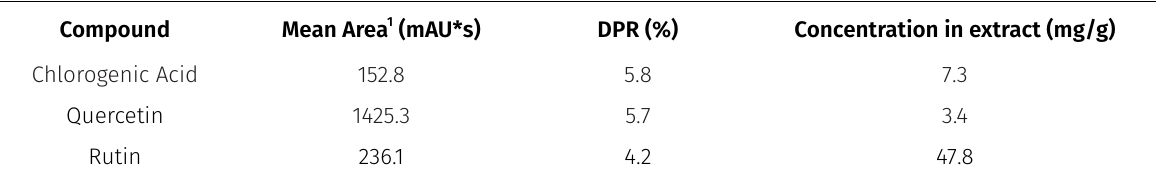
Figure 2. Enlargement of the ESI(-)-MS spectrum of S. microglossa flowers in the mass range of 300 to 500 m/z. Table III. Data for the quantification of chlorogenic acid, quercetin and rutin in the S. microglossa extract: average area, relative standard deviation (DPR) and concentration of the substance in the